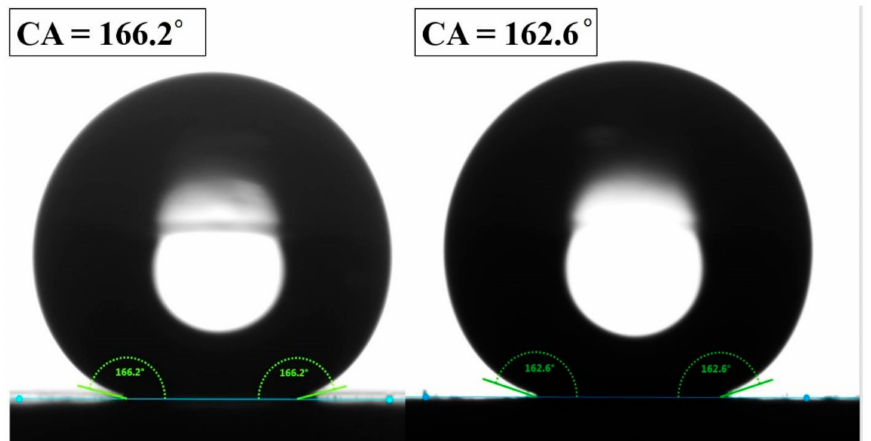
Figure 5. Static water contact angles obtained on ( a ) superhydrophobic aluminum surface with the Coating A and ( b ) superhydrophobic aluminum surface with the Coating